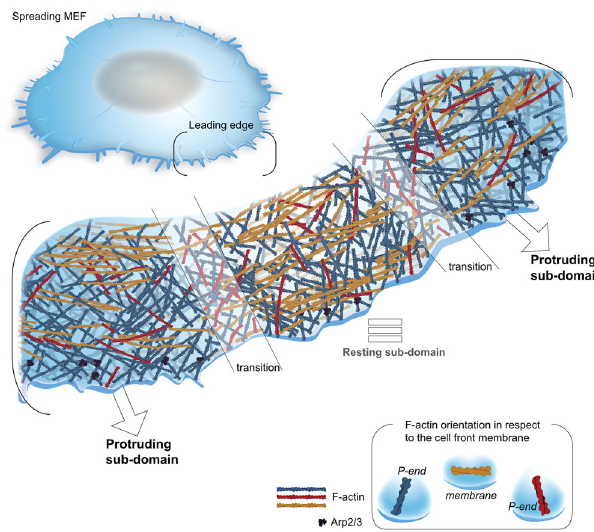
Fig. 6 The lamellipodia architecture in spreading cells. A model depicting the actin organization at the edge of a spreading cell. Three distinct actin sub-domain exhibit different directionality of actin fi laments were identi fi ed. A protruding sub-domain in which the majority of the actin fi laments have their barbed ends pointing towards the membrane (blue), while parallel fi laments (mustard) and fi laments that are pointing towards the cell body (red) can be detected as well. In the resting sub-domain, less fi laments are directed towards the membrane while more parallel fi laments are detected. Transition sub-domains are spaced between the protruding and resting sub-domains. In all the three network architectures, parallel oriented actin fi laments (mustard) are enriched in the resting sub-domains although they can also be seen in transition and protruding sub-domains. Similar amounts of fi laments that are pointing towards the cell body (red) were detected in all